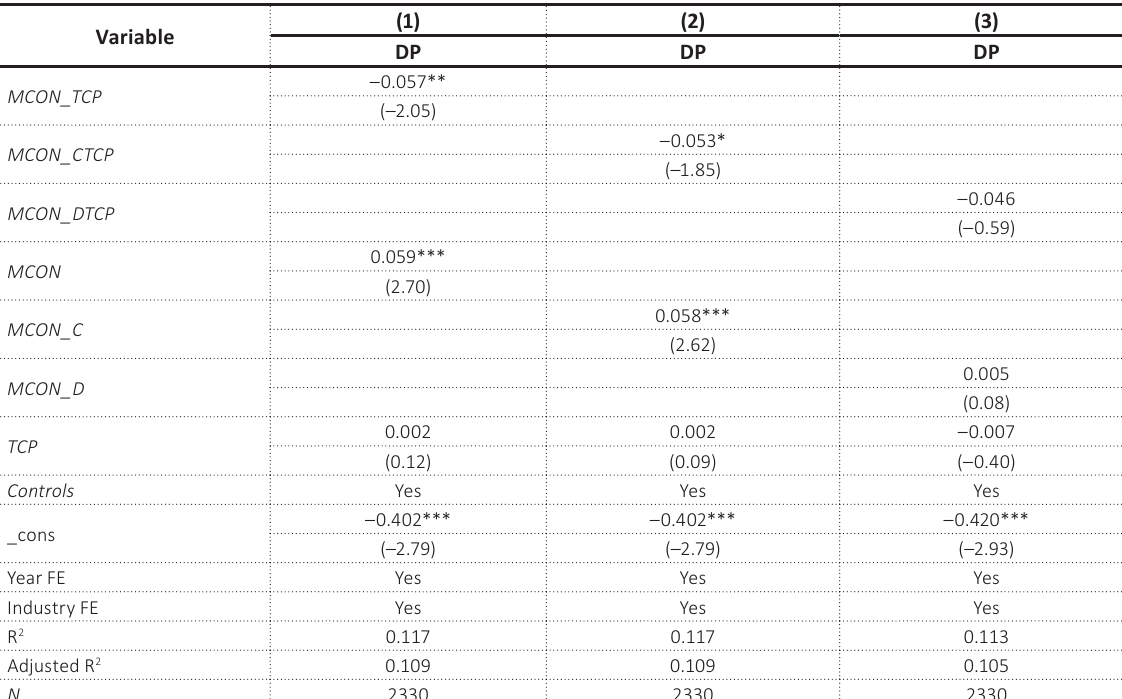
Table 6. Military-connected firms, debt policy, and thin capitalization